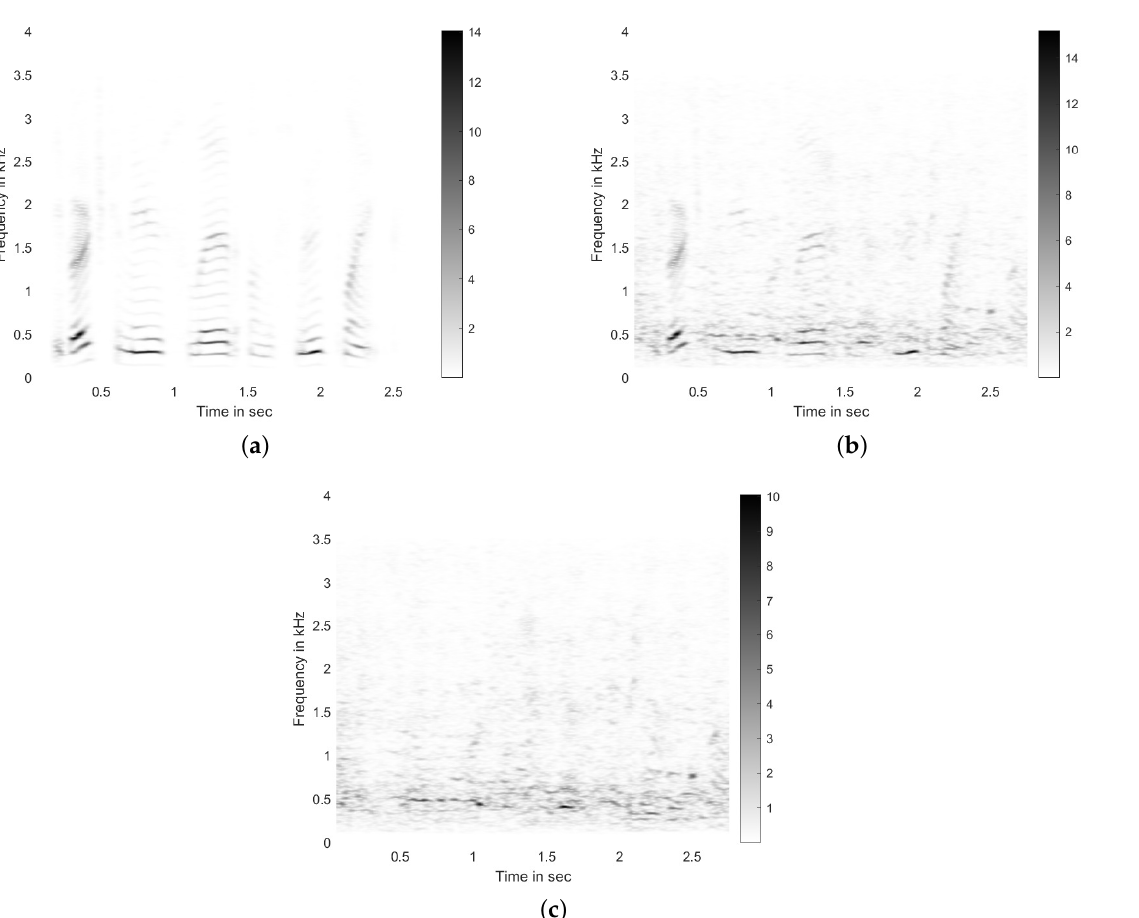
Figure 1. Magnitudes of short-time Fourier transforms of ( a ) clean signal s (n), ( b ) noise-contaminated signal y (n) with 0 dB signal-to-noise ratio, and ( c ) noise r